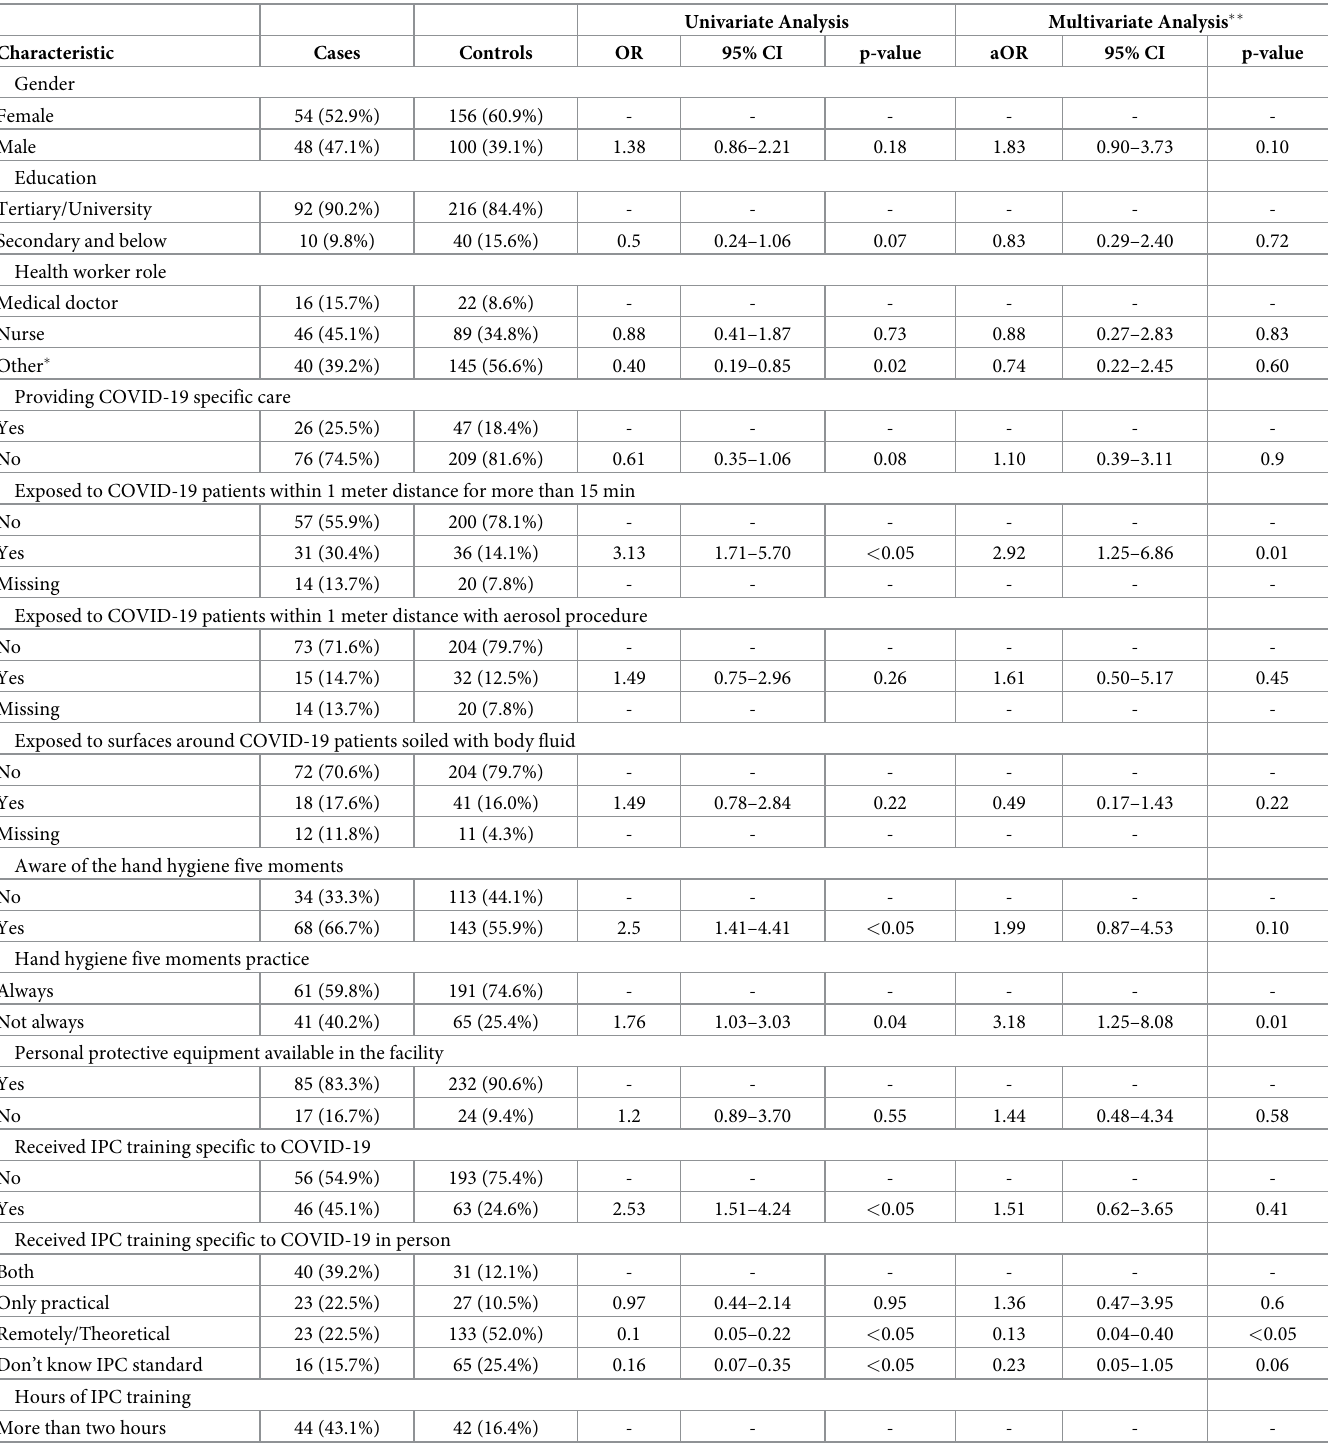
Table 1. Associations between demographic factors and IPC practices and COVID-19